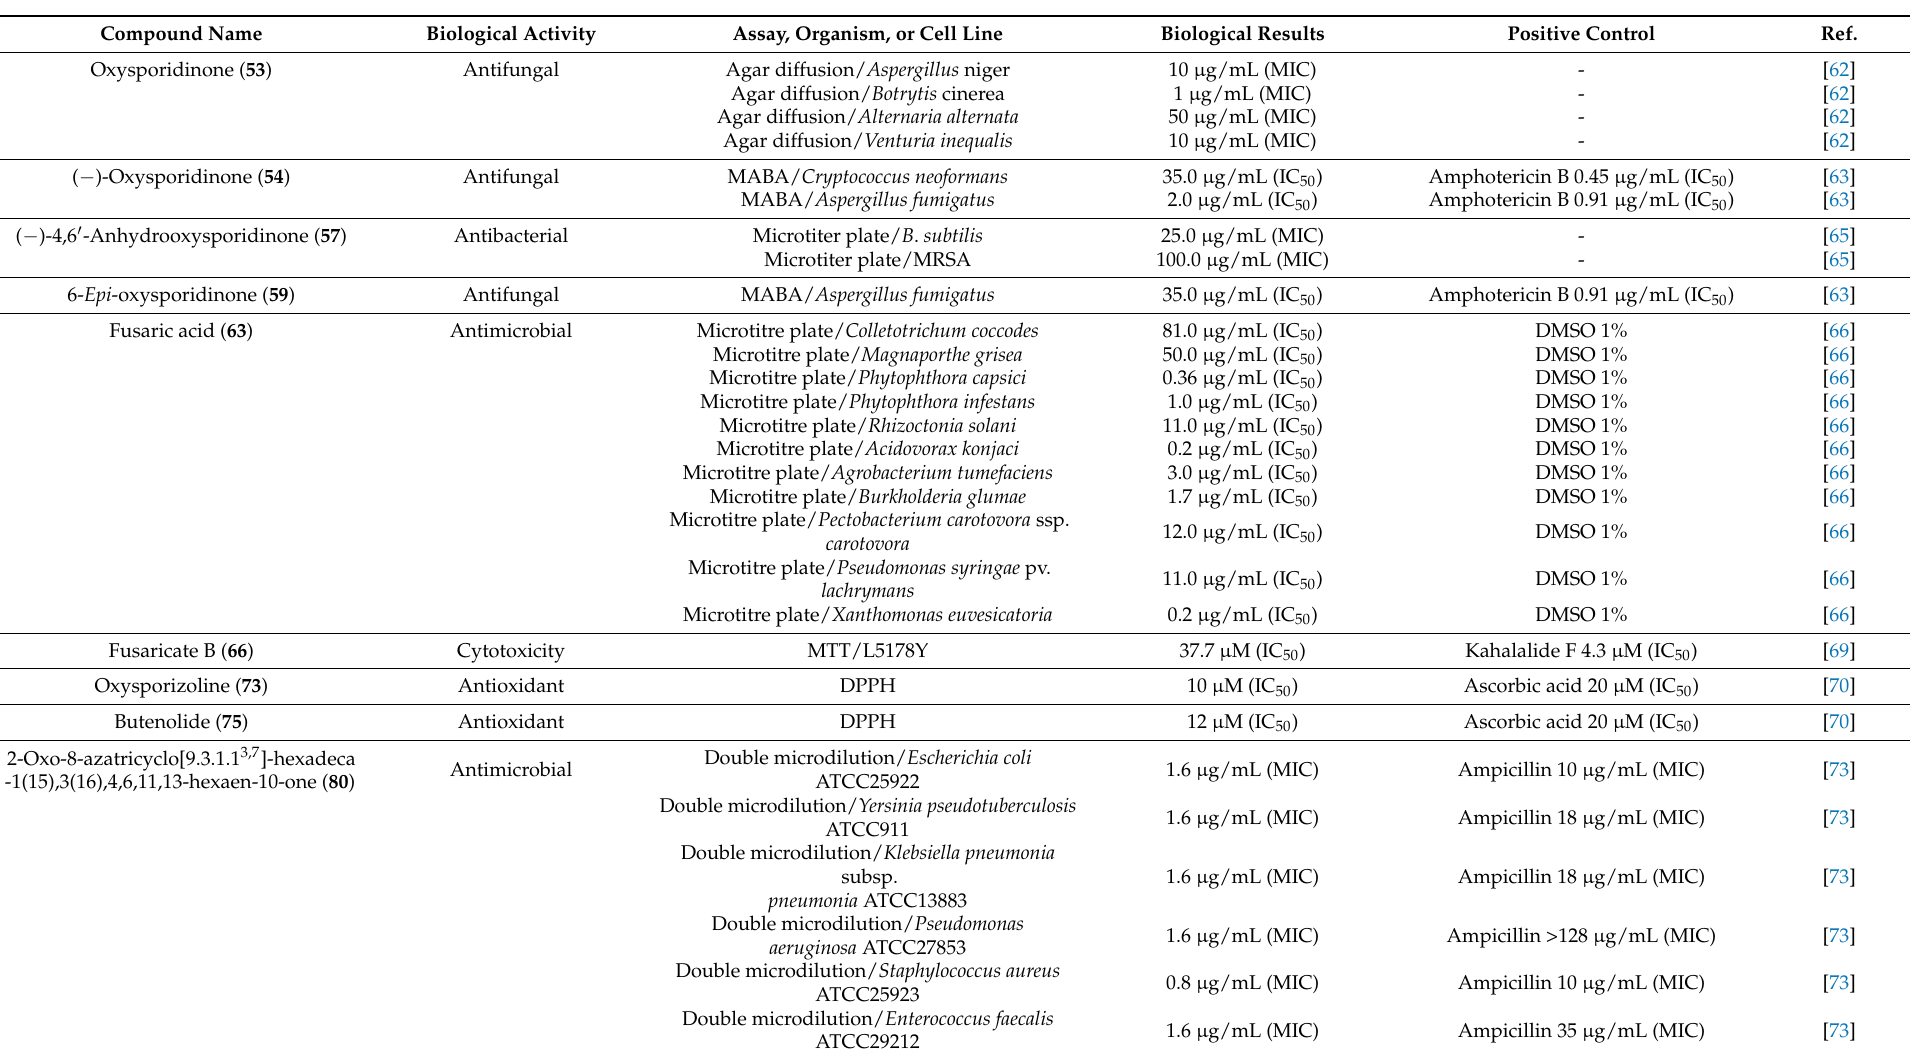
Table 2. Biological activities of the reported metabolites from F. oxysporum